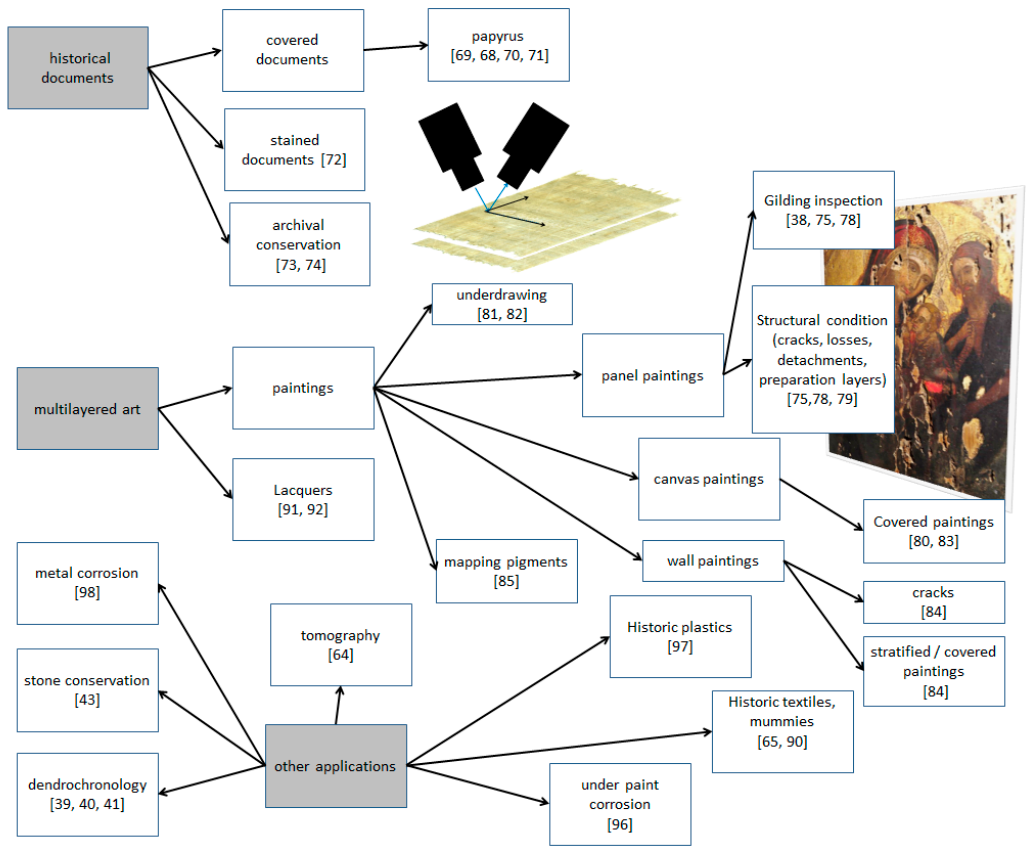
Figure 4. Applications of Terahertz in cultural heritage science.